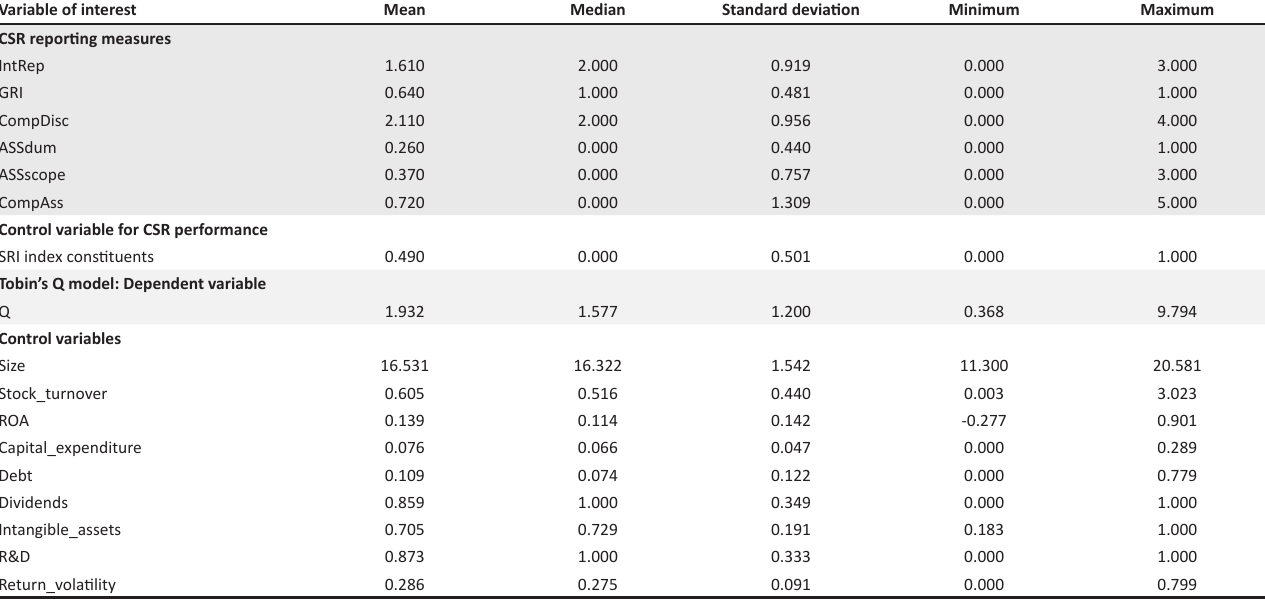
TABLE 2: Descriptive statistics for regression models. Variable of interest